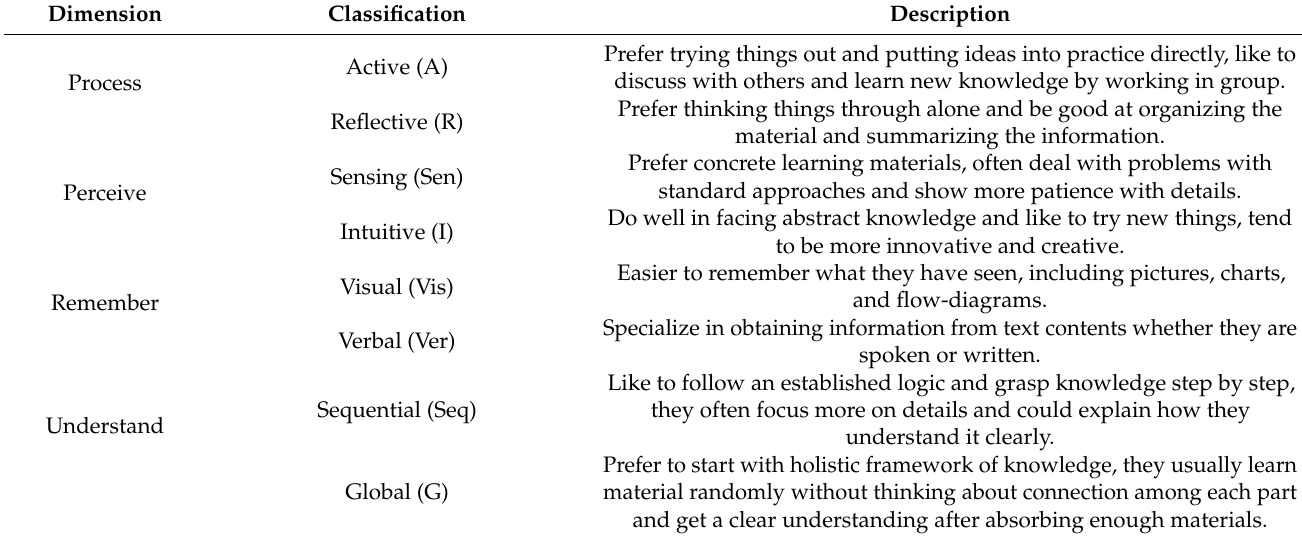
Table 1. The description of four learning styles.